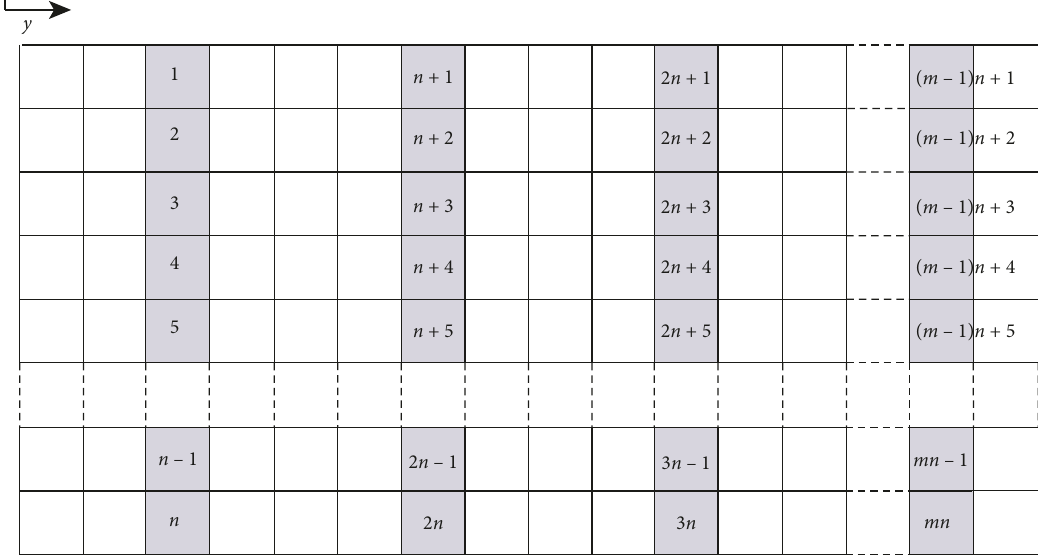
Figure 2: Example CPT data grid ( k � 1): global numbering of data points at a cross section.